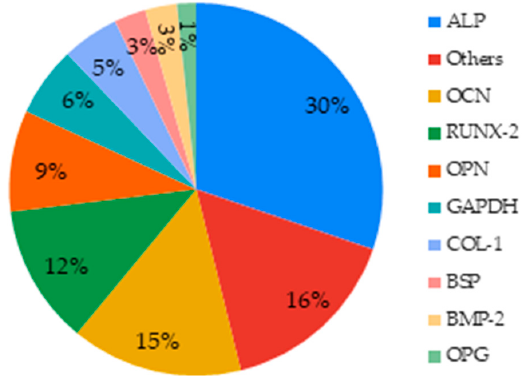
Figure 10. Markers studied to assess the effect of MBGs on cell differentiation.